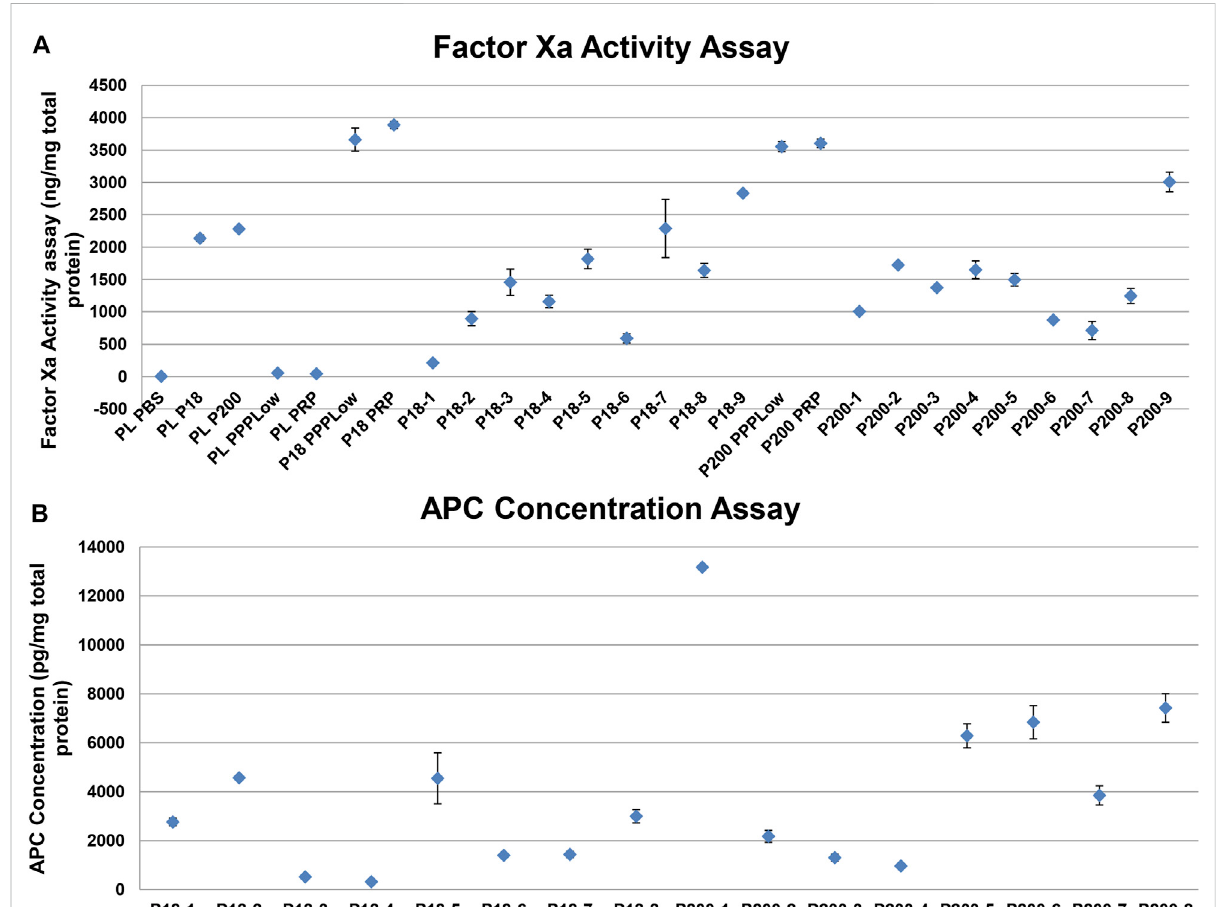
FIGURE 5 Activity measurement of factor Xa and activated protein C shows variable but de fi nite activity among individual samples. (A) Dot plot showing FactorXaactivity(withSDoftriplicates)invarioussamples.PLPBS(PlasmadilutedwithPBStosamevolumeasEVs).PLP18(PlasmadilutedwithP185: 4 at P18 concentration of 50 µg/m). PLP200 (Plasma diluted with P200, 5:4 at P200 concentration of 50 µg/ml). PLPPPLow and PLPRP (diluted plasma with the PPPLow reagent and the PRP reagent at 4:1). P18 (Microvesicles without any addition), P200 (Exosomes without any addition), P18PPPLow and P18PRP (P18 supplemented with the PPPLow and the PRP reagent, respectively at 4:1). P200PPPLow and P200PRP (P200 supplemented with the PPPLow and the PRP reagent, respectively at 4:1). (B) Activated protein C (APC) activity in P18 (Microvesicles) per 1mg oftotal proteinfrom 8donors (P18-1 to P18-8), and theAPC activityin P200(Exosomes) per 1mgof totalprotein from8donors(P200-1to P200-8), using the fl uorescent substrate-based